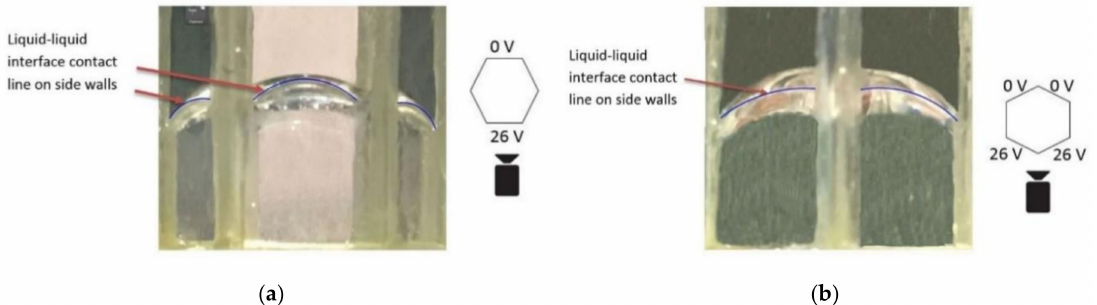
Figure 13. ( a ) Contact angle change viewed through the cell’s electrode face with an applied voltage of 26 V, ( b ) contact angle change viewed through the two-adjacent electrode faces with an applied voltage of 26